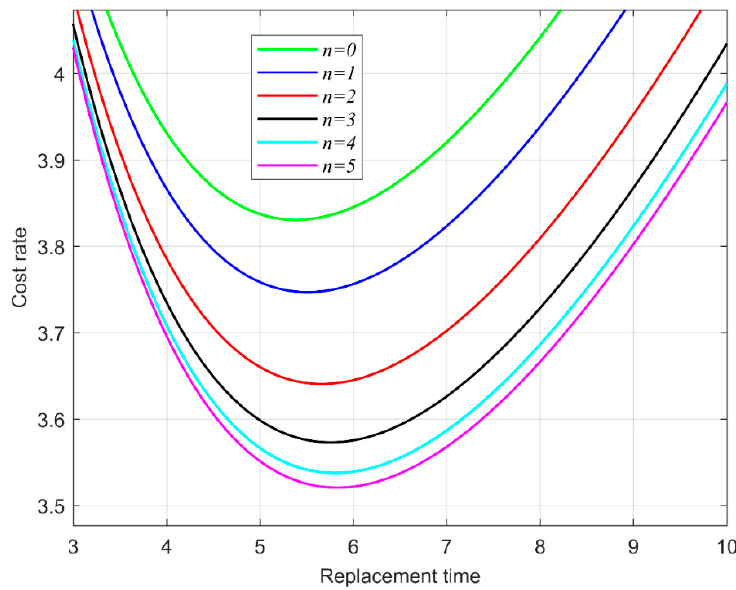
Figure 5. The existence of the optimal post-warranty maintenance policy.